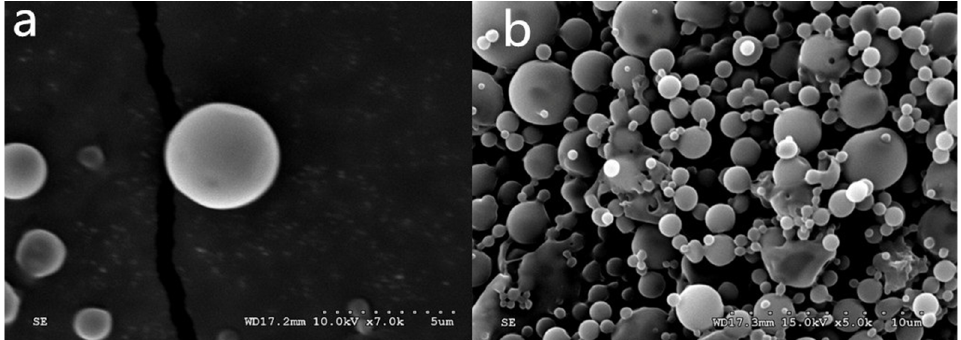
Figure 1. The antimicrobial peptide-PLGA microspheres SEM results; ( a , b ) correspond to different amplification lyophilized microspheres, multiples of ( a ) ×7000, ( b ) ×5000. The particle size distribution range was 0.5–3 µ m, and the polydispersity was 0.239 (Figure 2). Most of the particle size distribution was in the range of 800–1400 nm. A monodis- perse system can make the dose more reliable and more accurate. The carrier of a particle size less than 1 micron can be avoided by capillary blockage and filtration, which can be effectively absorbed by the cells [40]. Such a particle size distribution is suitable for drug